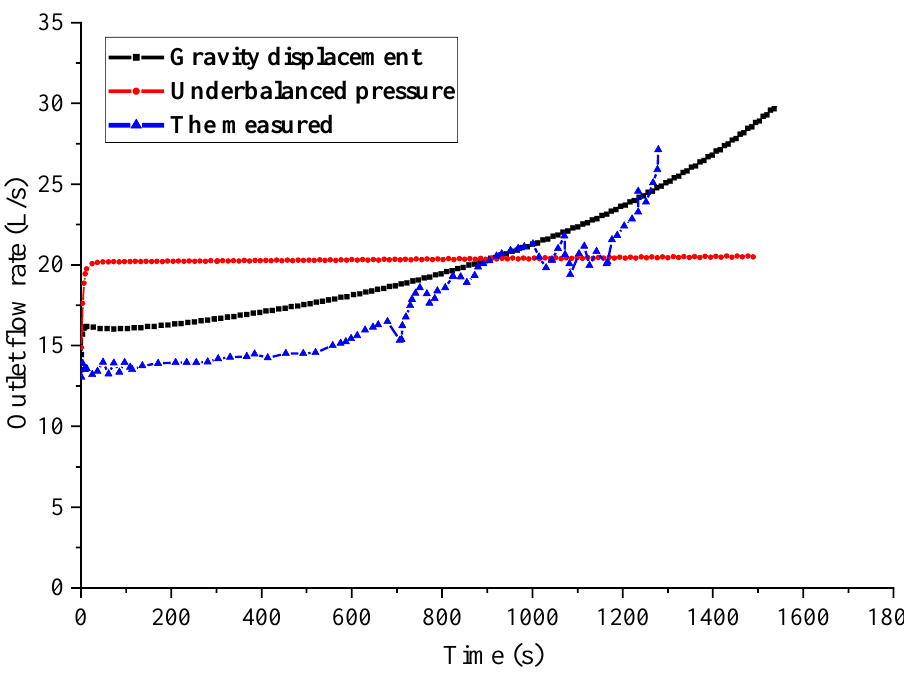
Figure 11. Identification of the gas kick type for well L. The DTW algorithm is used to calculate the DTW distance between time series C and time series A and B at different times, respectively.